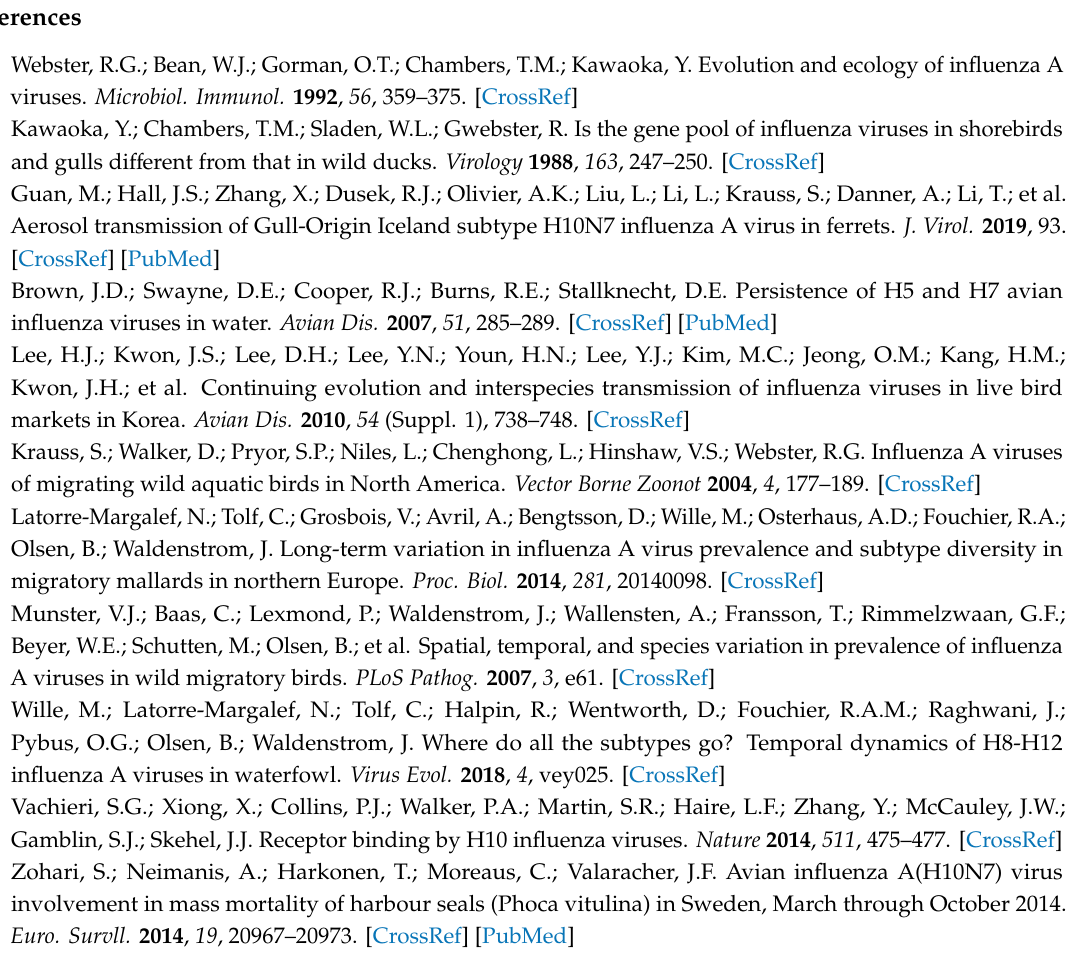
Figure S1: Phylogenetic trees of the internal genes of the H10-H12 subtype isolates found in Shanghai, China, Table S1: Viruses in the GenBank database exhibiting the highest homology with the H10-H12 subtype isolates in this